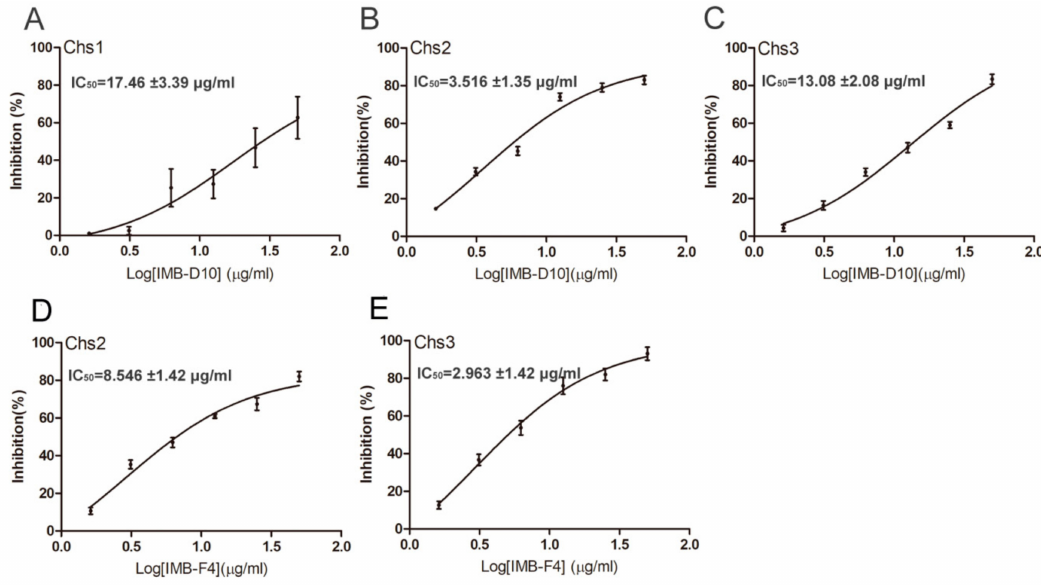
Figure 4. The inhibition of chitin synthesis activity of Chs1, Chs2, and Chs3 by compounds IMB-D10 and IMB-F4. ( A – C ). The inhibition of chitin synthase activity by IMB-D10. WT yeast cells were grown in YPD medium to OD 600 = 1–2. Then, membrane proteins were prepared accordingly and used to analyze the activity of chitin synthases. A 96-well plate coated with 50 µ g / mL wheat germ agglutinin (WGA) was used to detect chitin content. The reaction without uridine 5 (cid:48) -diphosphate- N –acetylglucosamine (UDP-GlcNAc) was used to measure the background absorbance. All reactions were carried out in triplicate. Data are presented as mean ± SD, and IC 50 is shown. ( D and E ). The inhibition of Chs2 and Chs3 activity by IMB-F4. The same method was used for the